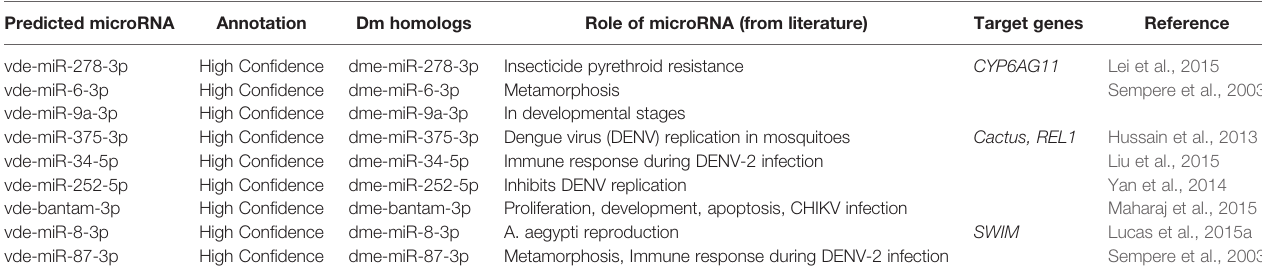
TABLE 2 | List of potential microRNA candidates predicted in this study, conserved in Drosophila melanogaster (Dm), and with evidence in the available literature play a signi fi cant role in the development, replication, harboring, and inhibition of viral pathogens. Predicted